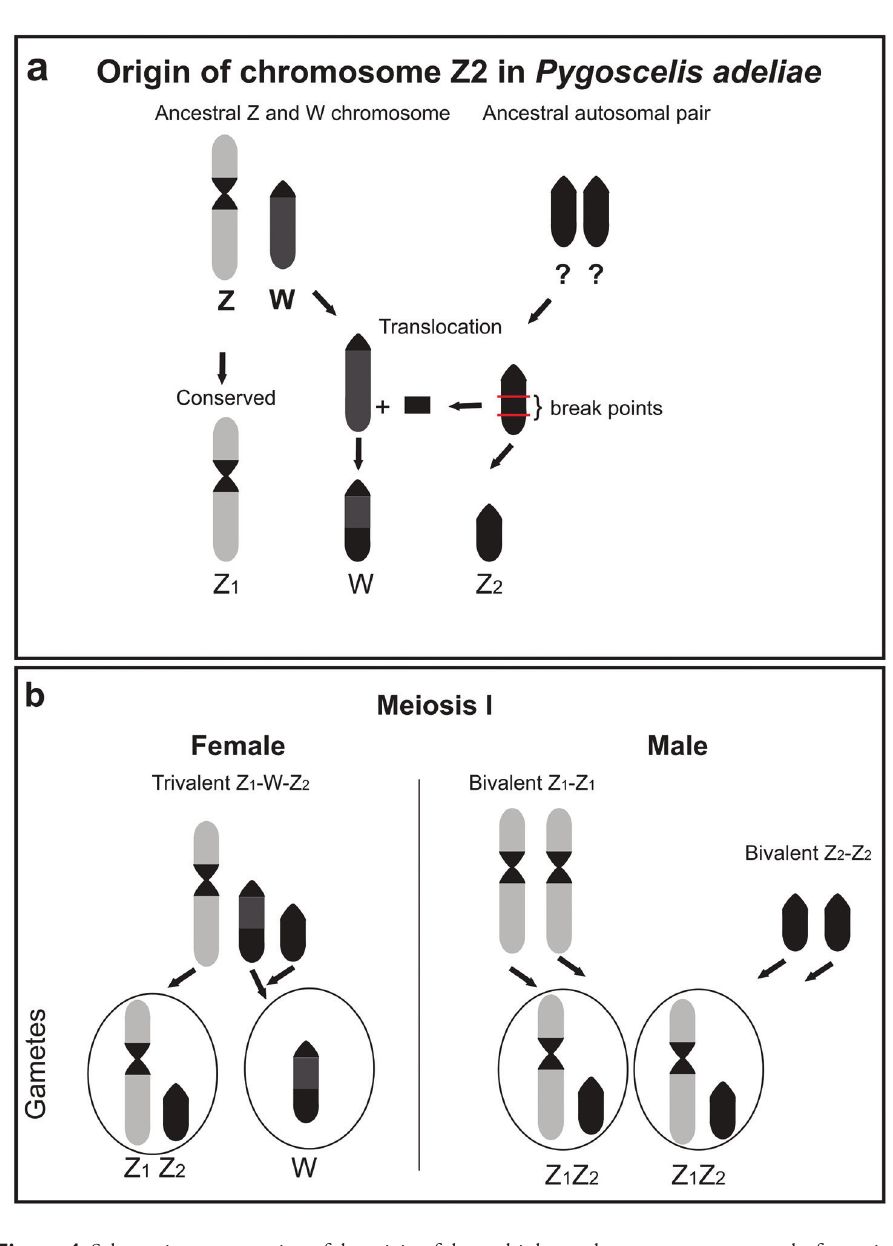
Figure 4. Schematic representation of the origin of the multiple sex chromosome system and a formation of the gametes during the meiosis I in Pygoscelis adeliae a The chromosomal translocation, which involving a heterochromatic segment of the ancestral chromosome Z2 with a terminal portion of the q arm of W chromosome b The meiosis in females and males of proposing the balanced gametes